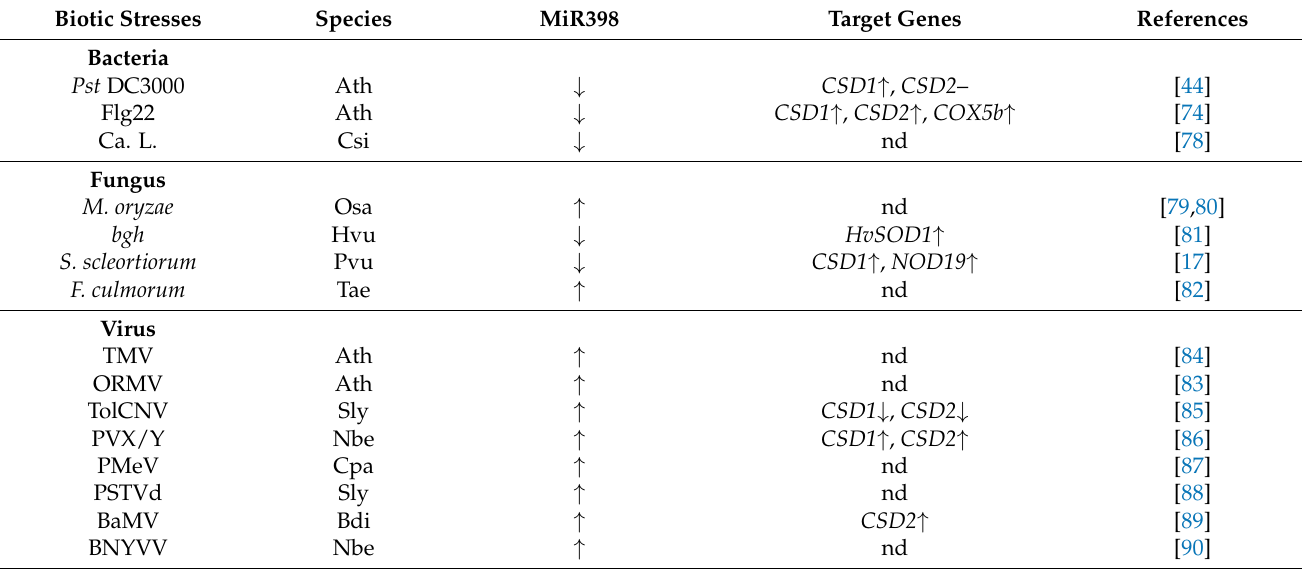
Table 2. MiR398 responses to biotic stresses in diverse plant